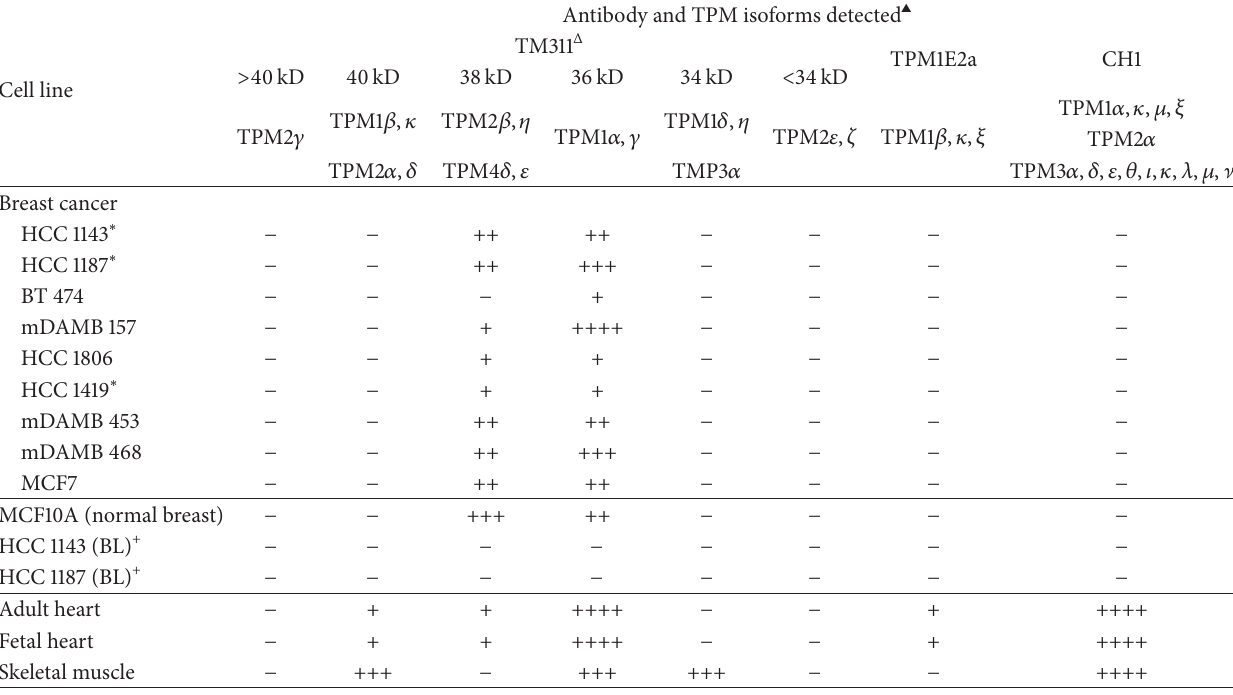
Table 4: Tropomyosin 1 protein expression in breast cancer cell